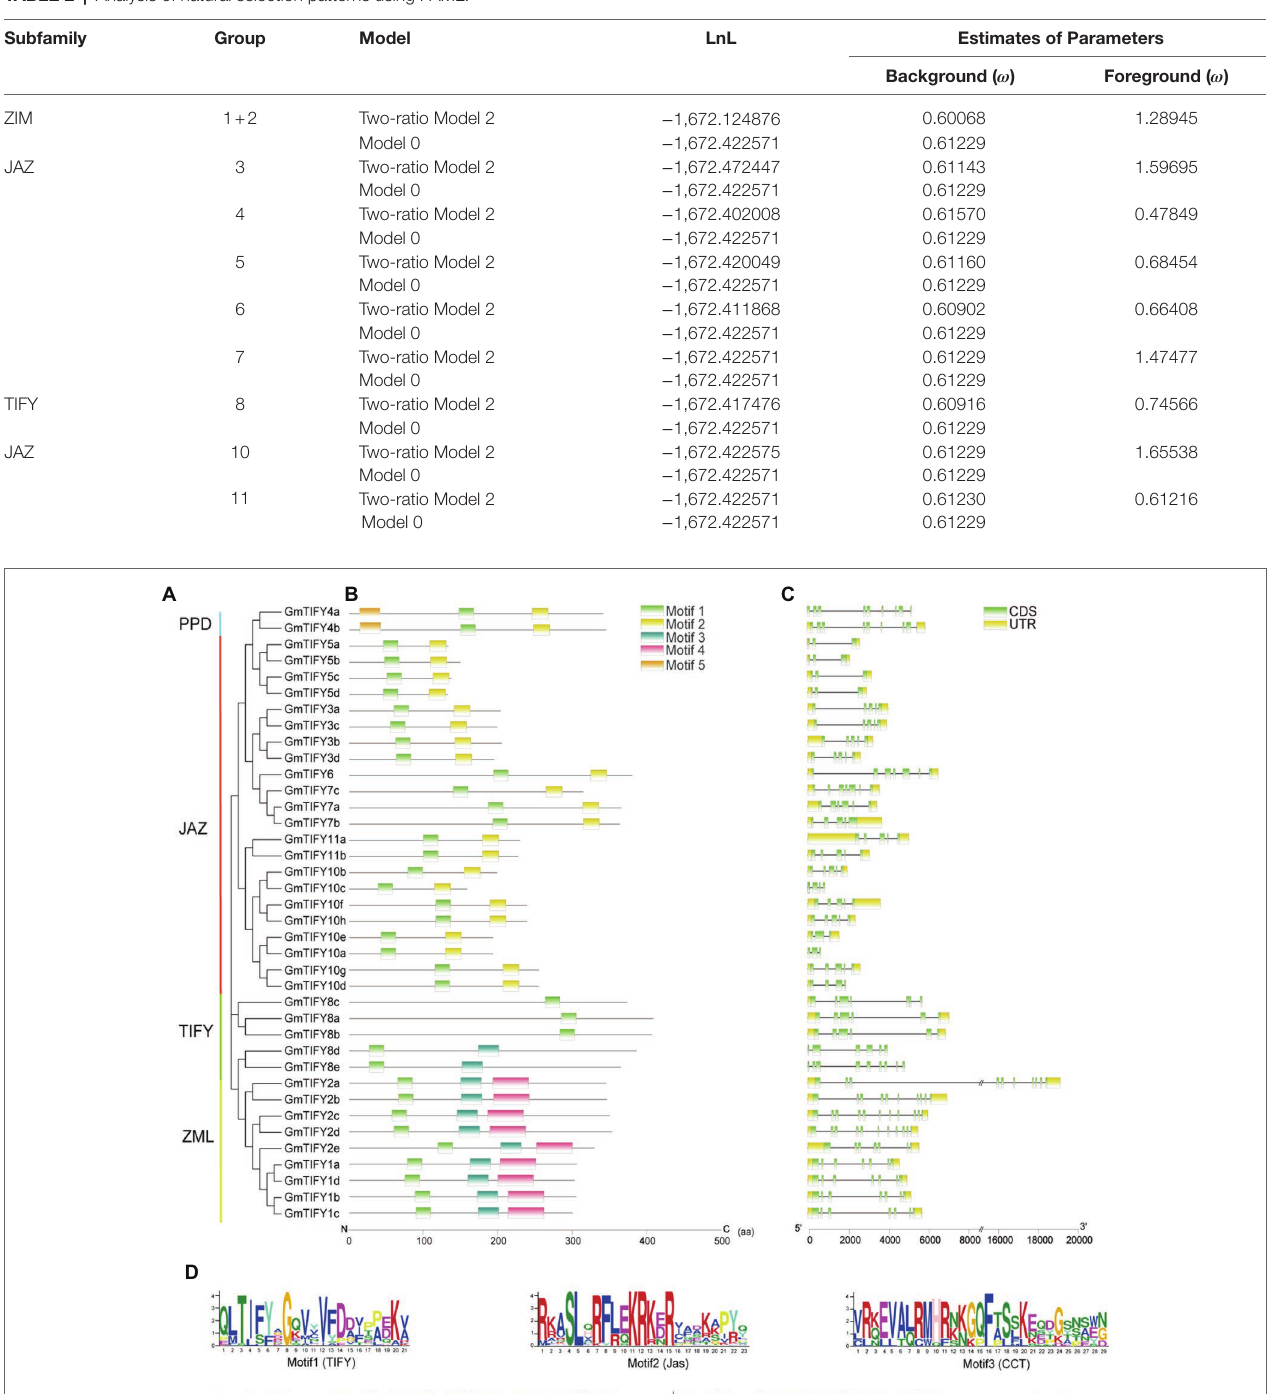
TABLE 2 | Analysis of natural selection patterns using